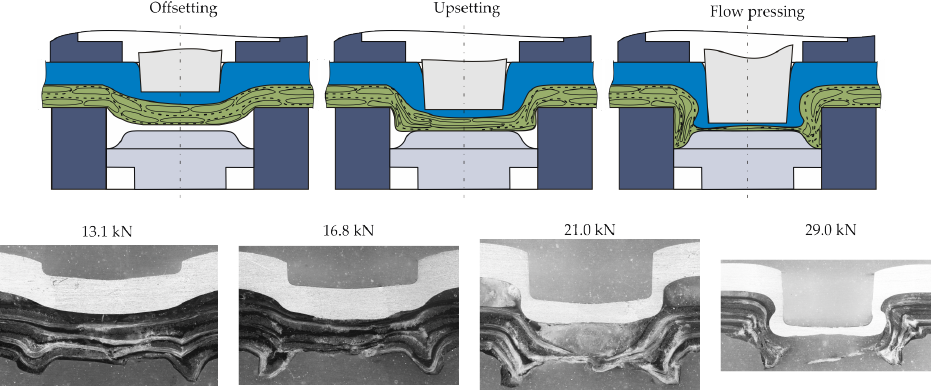
Figure 3. Schematic illustration and micrographs of the material structure at the different phases. In the centre area under the punch (bottom area) fibre failure increases. The fragments were displaced in radial direction to the ring groove. The cross section of yarns in transverse direction changes during these compaction and displacement processes and the fibres are also displaced in radial direction. The phenomena are simplified and illustrated in Figure